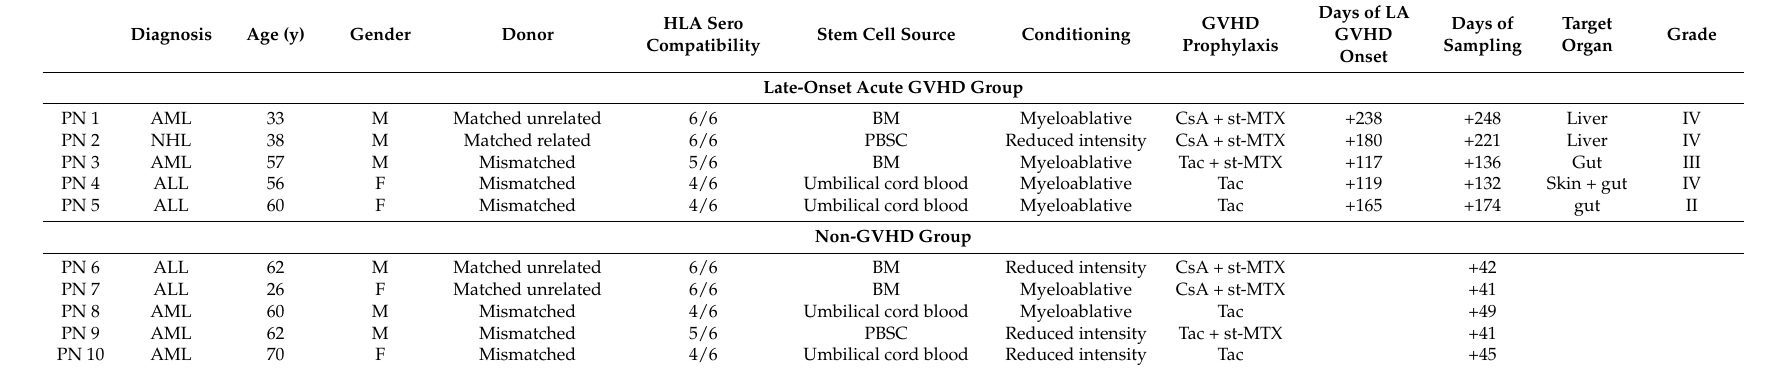
Table 1. Characteristics of hematopoietic stem cell transplantation (HSCT)